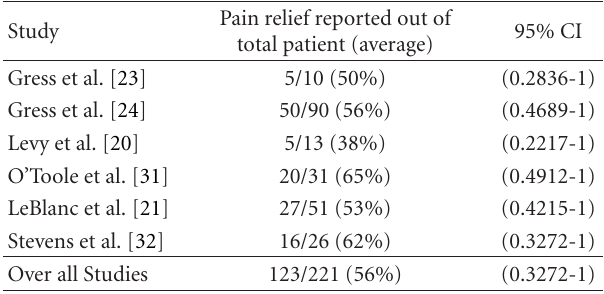
Table 1: Meta-analysis of EUS-guided celiac plexus block for chronic pancreatitis. The lower end of the confidence interval was used as the overall percentage of pain relief (adapted from Kaufman et al.